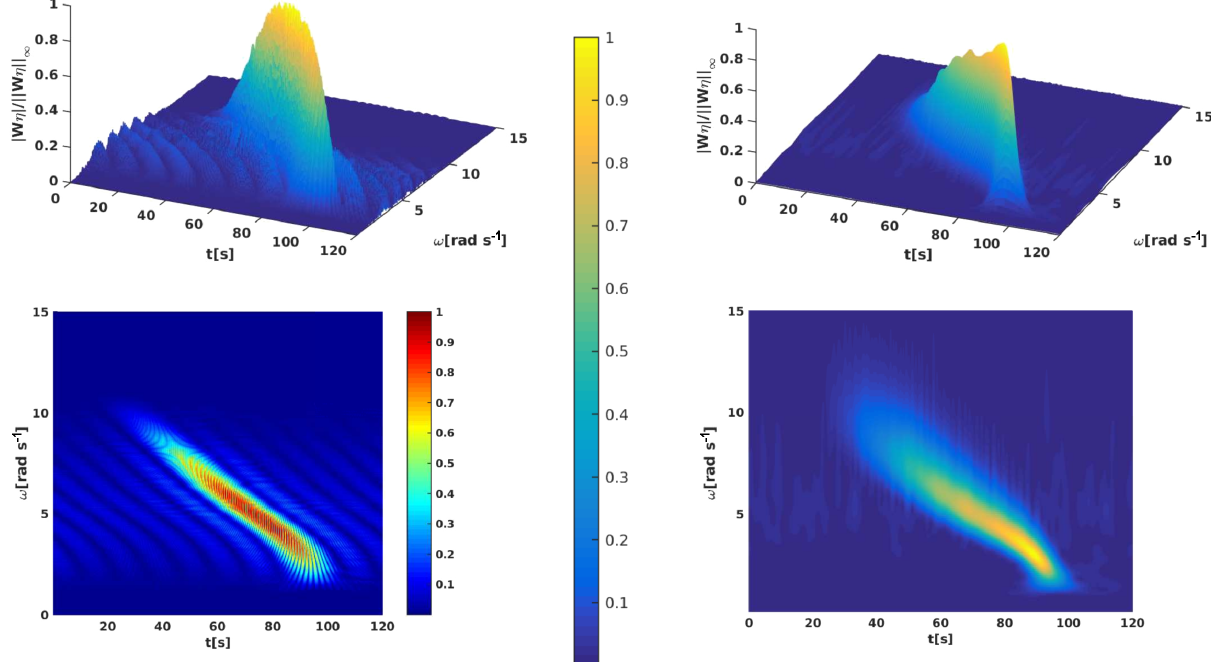
Figure 5. Shown is the distribution of the local energy of the dispersive focusing wave at some positions before the focusing point. The left plots are computed by Fourier transform and the right plots are by wavelet transform. The upper plots are in 3-D view, while the lower plots are in 2-D